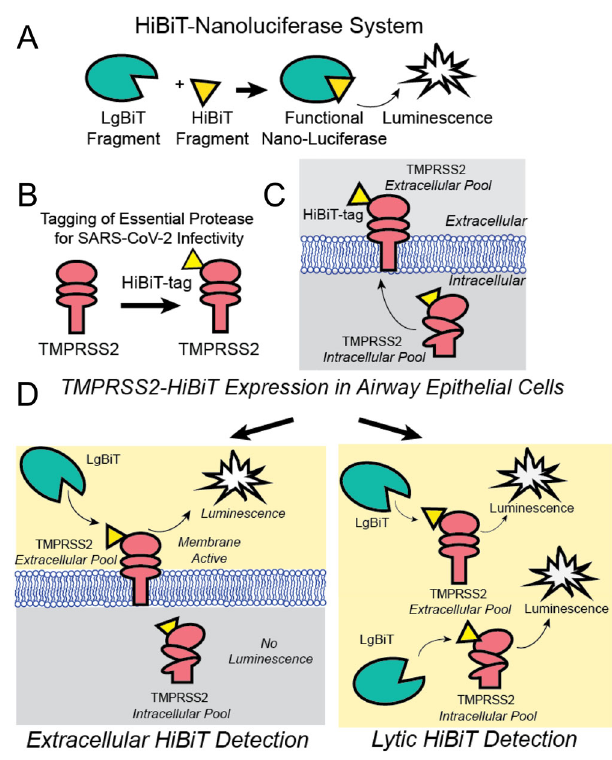
Fig. 1 Schematic of TMPRSS2-HiBiT detection for high-throughput screen. A The split nano-luciferase components LgBiT and HiBiT can interact to form a functional enzyme that generates luminescence. B Human TMPRSS2 cDNA was C-terminally tagged with a HiBiT sequence on a domain that is extracellular when TMPRSS2 is present in the plasma membrane. C The TMPRSS2-HiBiT construct was expressed in human airway cells where it exists in an intracellular pool and a plasma membrane- associated pool. D Non-lytic extracellular HiBiT detection results in LgBiT- HiBiT complementation solely with the pool of plasma membrane localized TMPRSS2. Following extracellular HiBiT detection, cells are lysed and the total TMPRSS2- HiBiT is then quanti fi